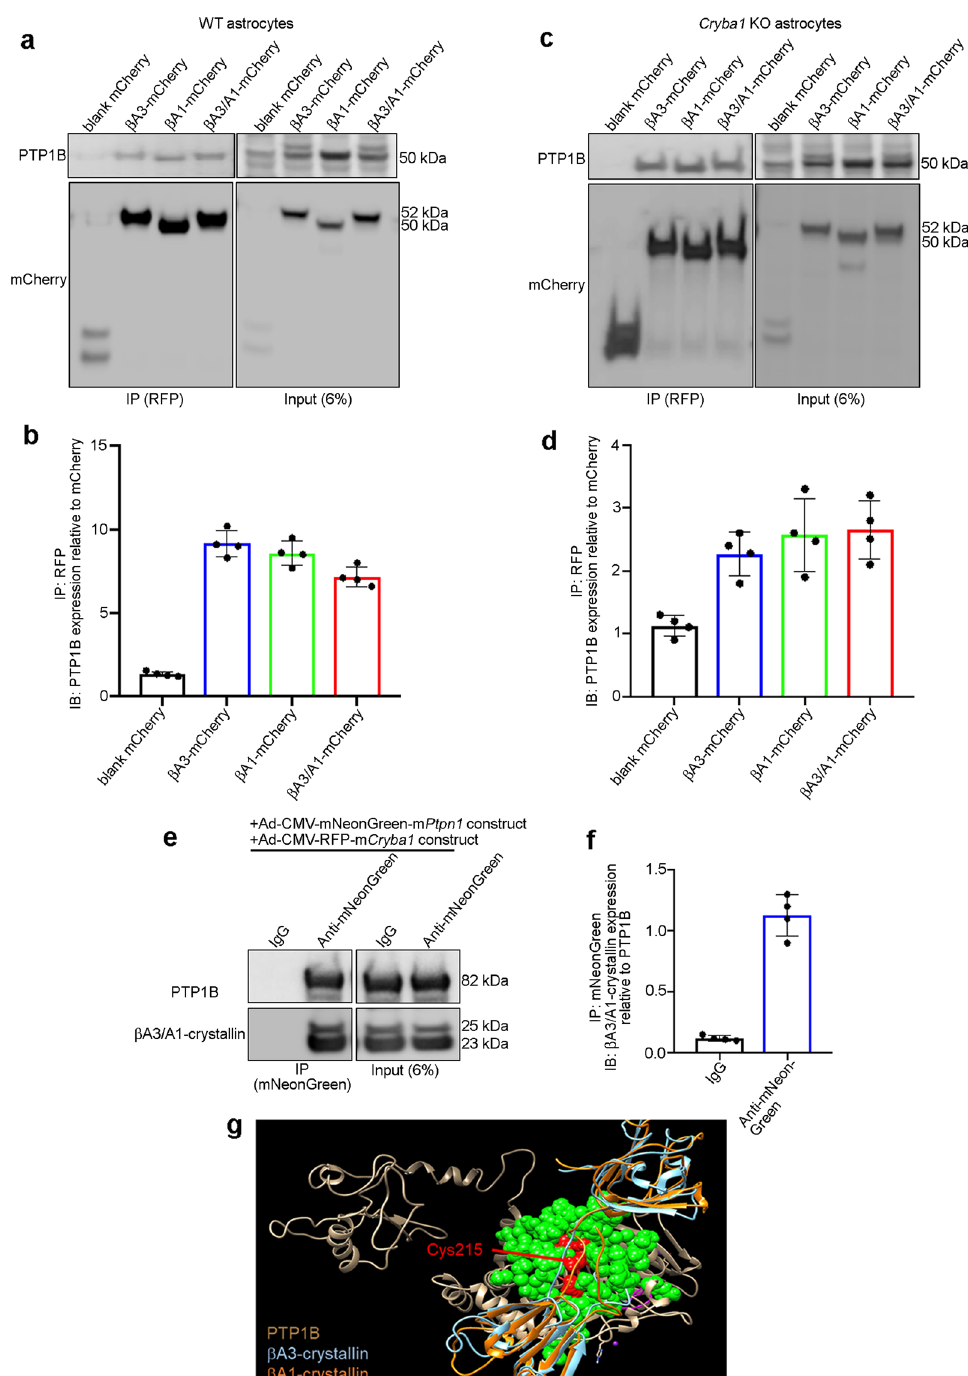
Fig. 1 β A1-crystallin is a binding partner of PTP1B. Representative western blot and densitometry graph from co-immunoprecipitation studies in mouse WT ( a , b ) or Cryba1 KO ( c , d ) astrocytes transfected with blank-mCherry, β A3-crystallin-mCherry ( β A3-mCherry), β A1-crystallin-mCherry ( β A1-mCherry), and β A3/A1-crystallin-mCherry ( β A3/A1-mCherry) show interaction of PTP1B with both β A3- and β A1-crystallin; n = 4. e , f Co-immunoprecipitation assay showing β A3/A1-crystallin levels in the Co-IP eluent by western blot analysis and densitometry, indicating binding to PTP1B, upon pull down with mNeonGreen antibody-bound magnetic beads from lysates of astrocytes overexpressing PTP1B (Ad-CMV-mNeonGreen-m Ptpn1 ) and Cryba1 (Ad-CMV- RFP-m Cryba1 ). Pull down with mouse IgG showed no binding for β A3/A1-crystallin; n = 4. g Ribbon diagram obtained by molecular modeling showing superimposed β A1-crystallin (orange), β A3-crystallin (blue), and PTP1B (gray). Neither isoform is able to bind to the pocket of PTP1B active site (Cys215, Red). The β A1, but not the β A3 isoform (due to a steric bump of terminal extension) interacts with an allosteric binding site (green) on the surface of PTP1B.